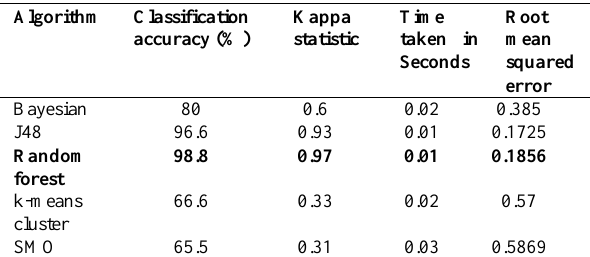
Table 4. Classification accuracy of the different algorithms in core data set.